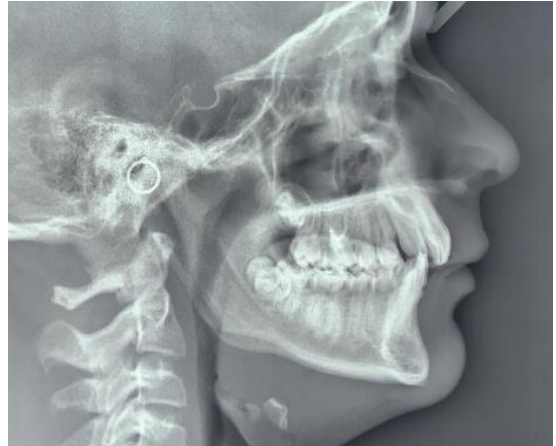
Figure 3. Deficient posterior atlas arch.